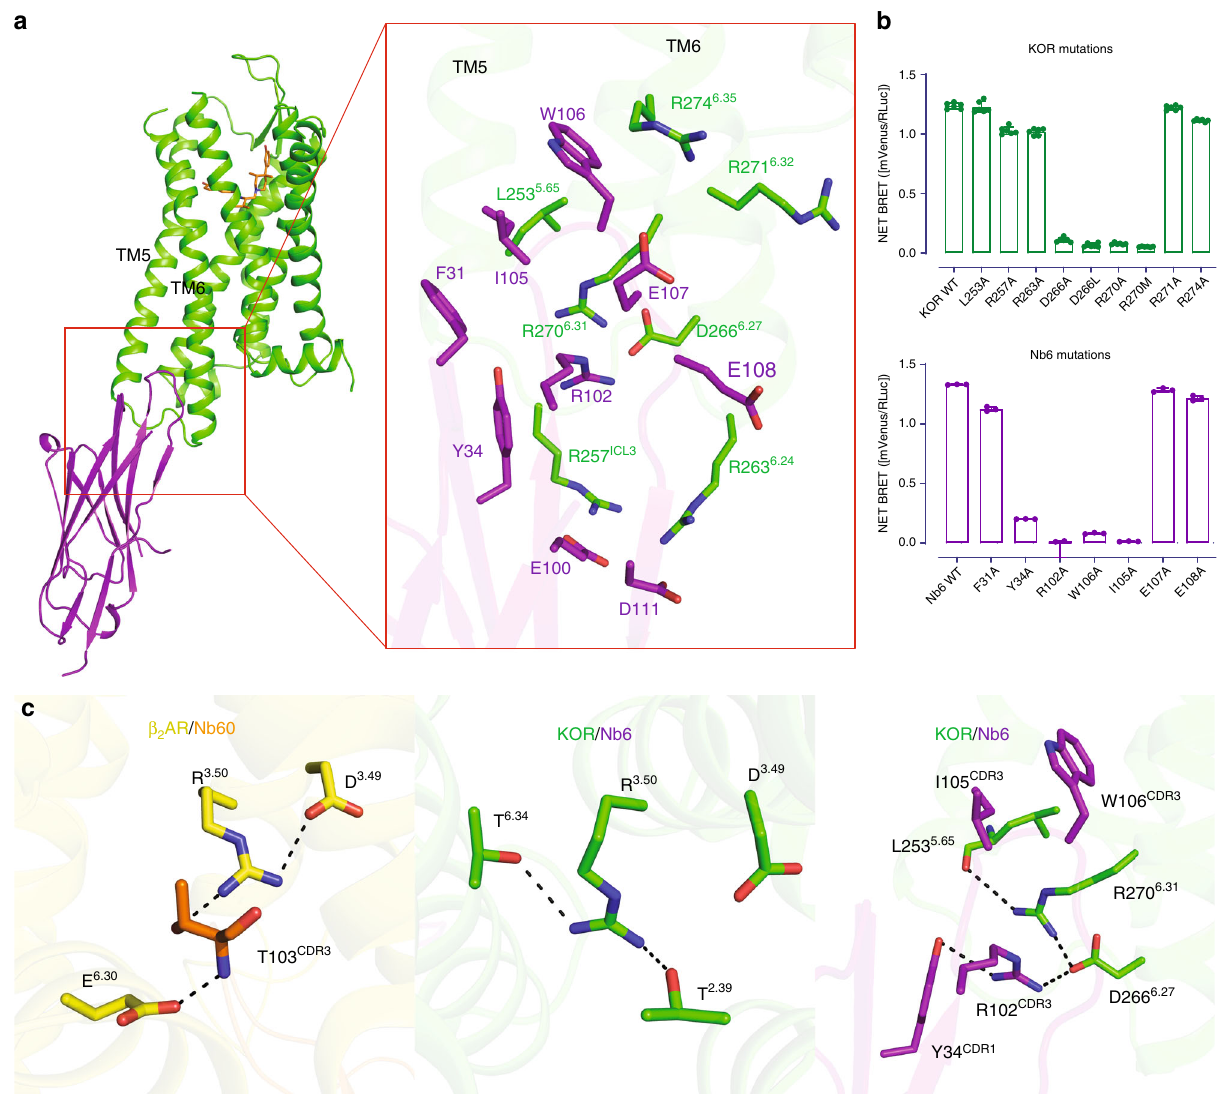
Fig. 3 Unique interface between KOR and Nb6. a Details of the interface between KOR (green) and Nb6 (purple) are shown. b Mutagenesis studies using BRET identify key residues essential for KOR – Nb6 interactions. Error bars represent SEM. ( N = 3) c left, ionic-lock in β 2 AR stabilizing the S2 inactive state; middle, R 3.50 forms two hydrogen bonds with T 2.39 and T 6.34 , respectively. These interactions mimic the ionic lock observed in β 2 AR; right, R102 in Nb6 mediates a new H-bond network between TM5 and TM6. This interaction is not observed in either KOR – JDTic inactive or KOR – Nb39 active states. Source data are provided as a Source Data fi